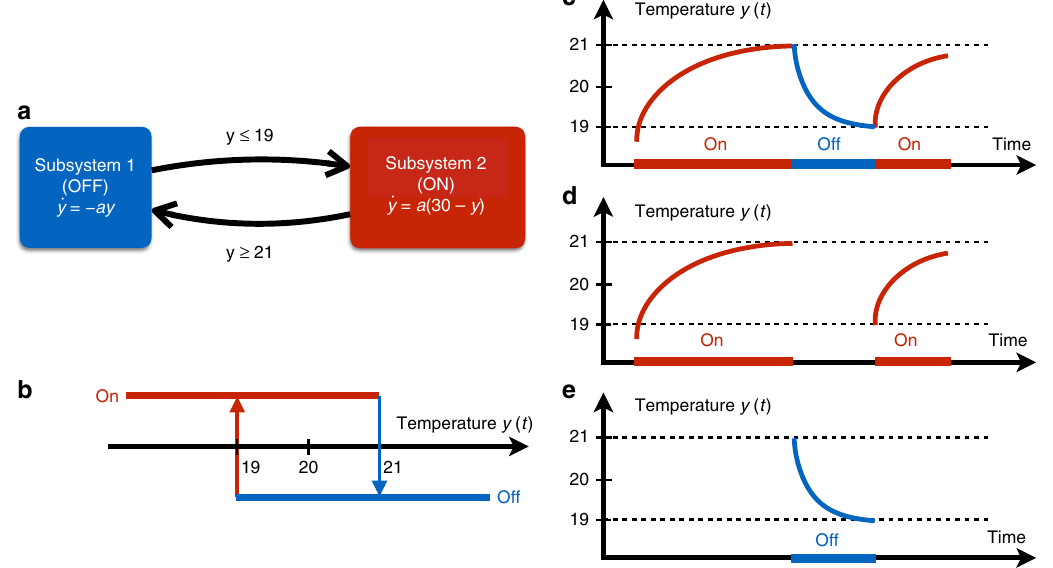
Fig. 1 An illustrative toy example on a thermostat. a The physical dynamic equations plus the transition rules of the hybrid dynamical system. A transition rule is to turn the heater on when the temperature falls below 19°C, and switch it off when it reaches 21°C. When the heater is off, the temperature y dissipates to the exterior at a rate of − ay ( t ) °C per hour, where a > 0 is related to the insulation of the room. When the heater is on, it provides a temperature increase rate of 30 a °C per hour. b Visualization of transition rules of the relay hysteresis based on the temperature of the room. c A simulation of the temperature of the thermostat system. Red (blue) is associated with the heater on (off). d , e Separated time series of the temperature corresponding to the heater on (off) from the original temperature data NATURE COMMUNICATIONS| (2019) 10:4894